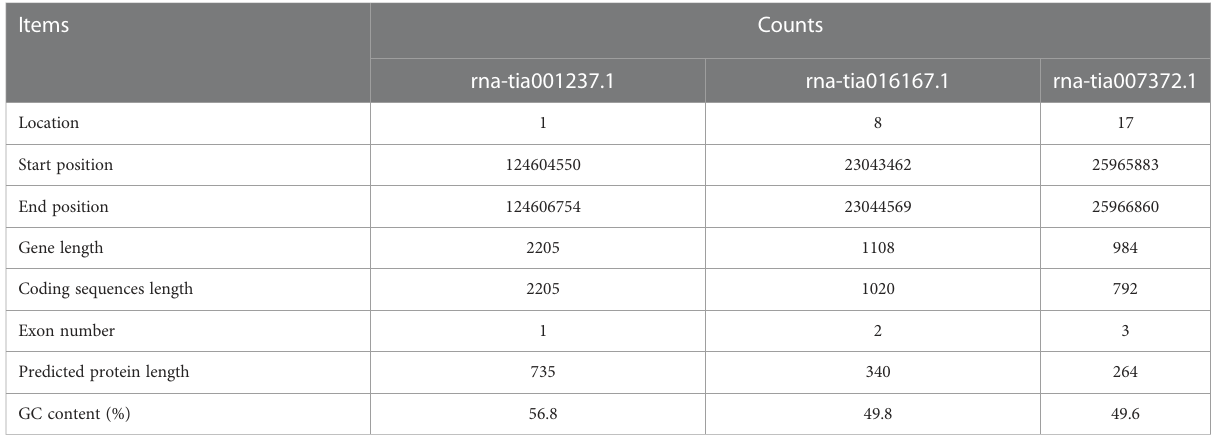
TABLE 2 Information of identi fi ed HGT genes.